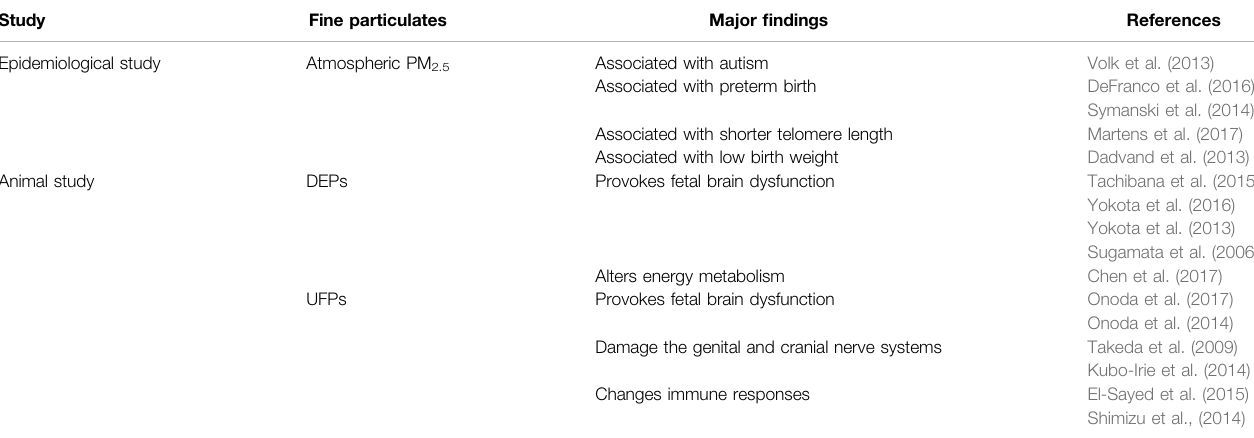
TABLE 3 | Studies linking fi ne particulates exposure with fetal